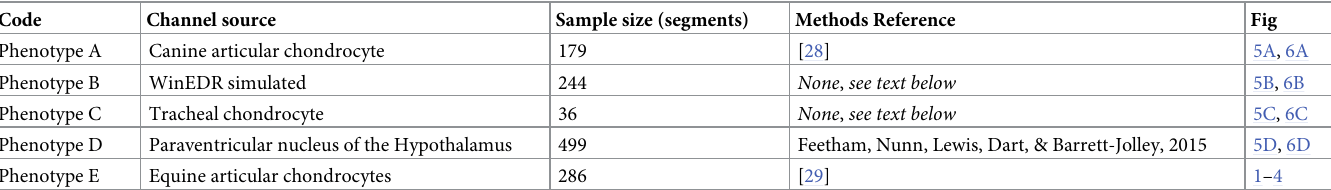
Table 1. Sources of raw data for development and testing of the GAN